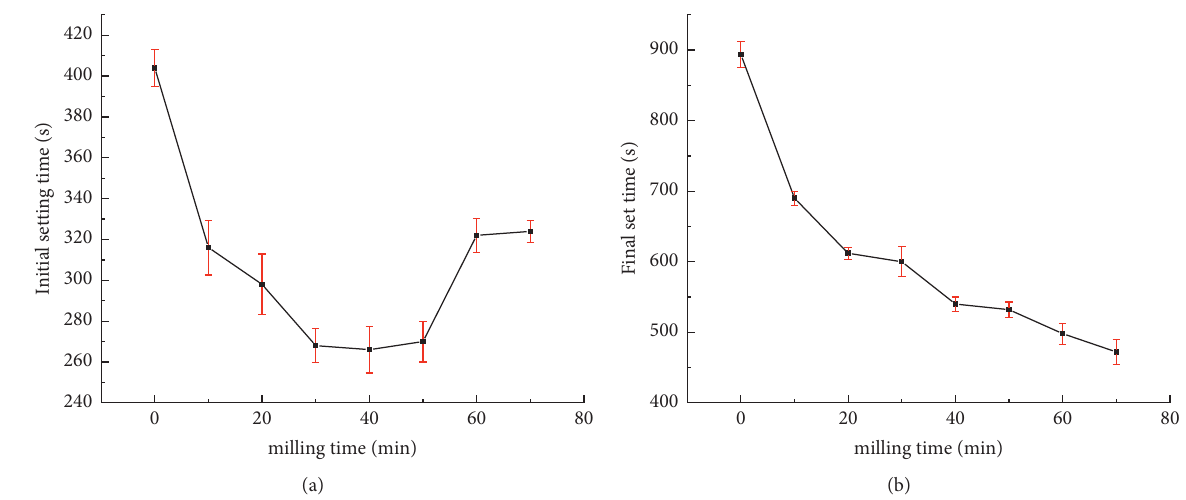
Figure 3: Variation of the setting time PBG with ball milling time. (a) Initial setting time. (b) Final setting